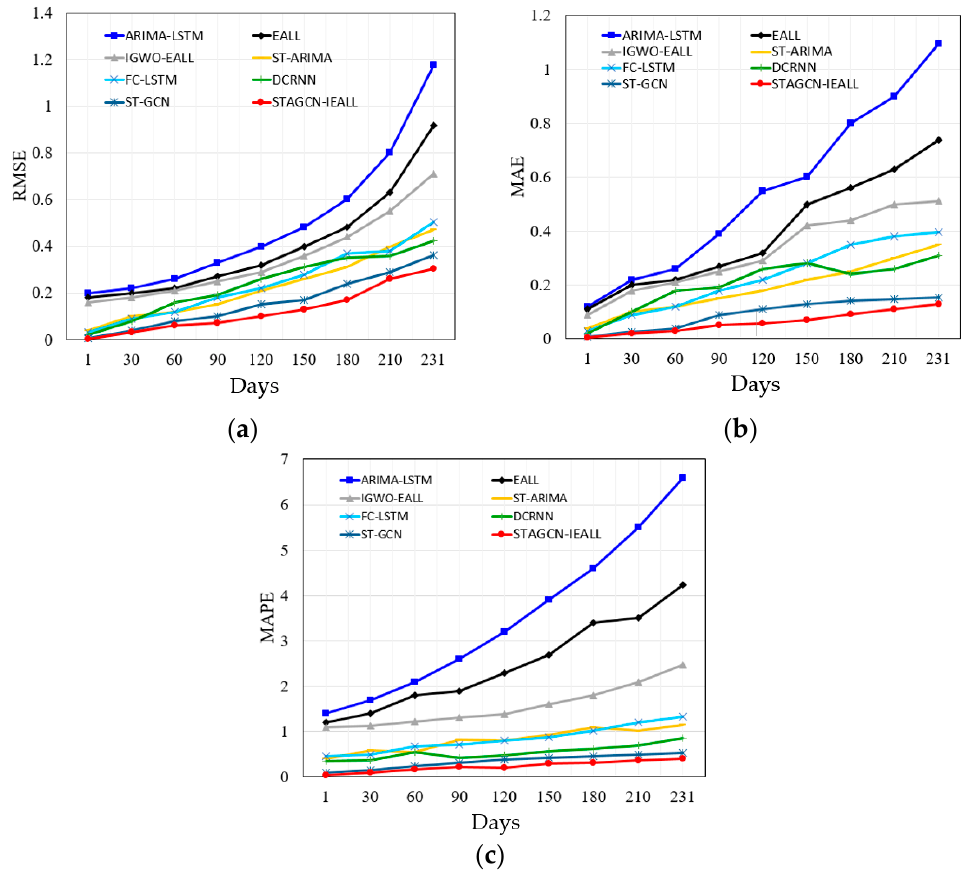
Figure 11. Variation curves of three evaluation indexes under di ff erent duration. ( a ) Curve of RMSE variation in di ff erent durations; ( b ) Curve of MAE variation in di ff erent durations; ( c ) Curve of MAPE variation in di ff erent durations.